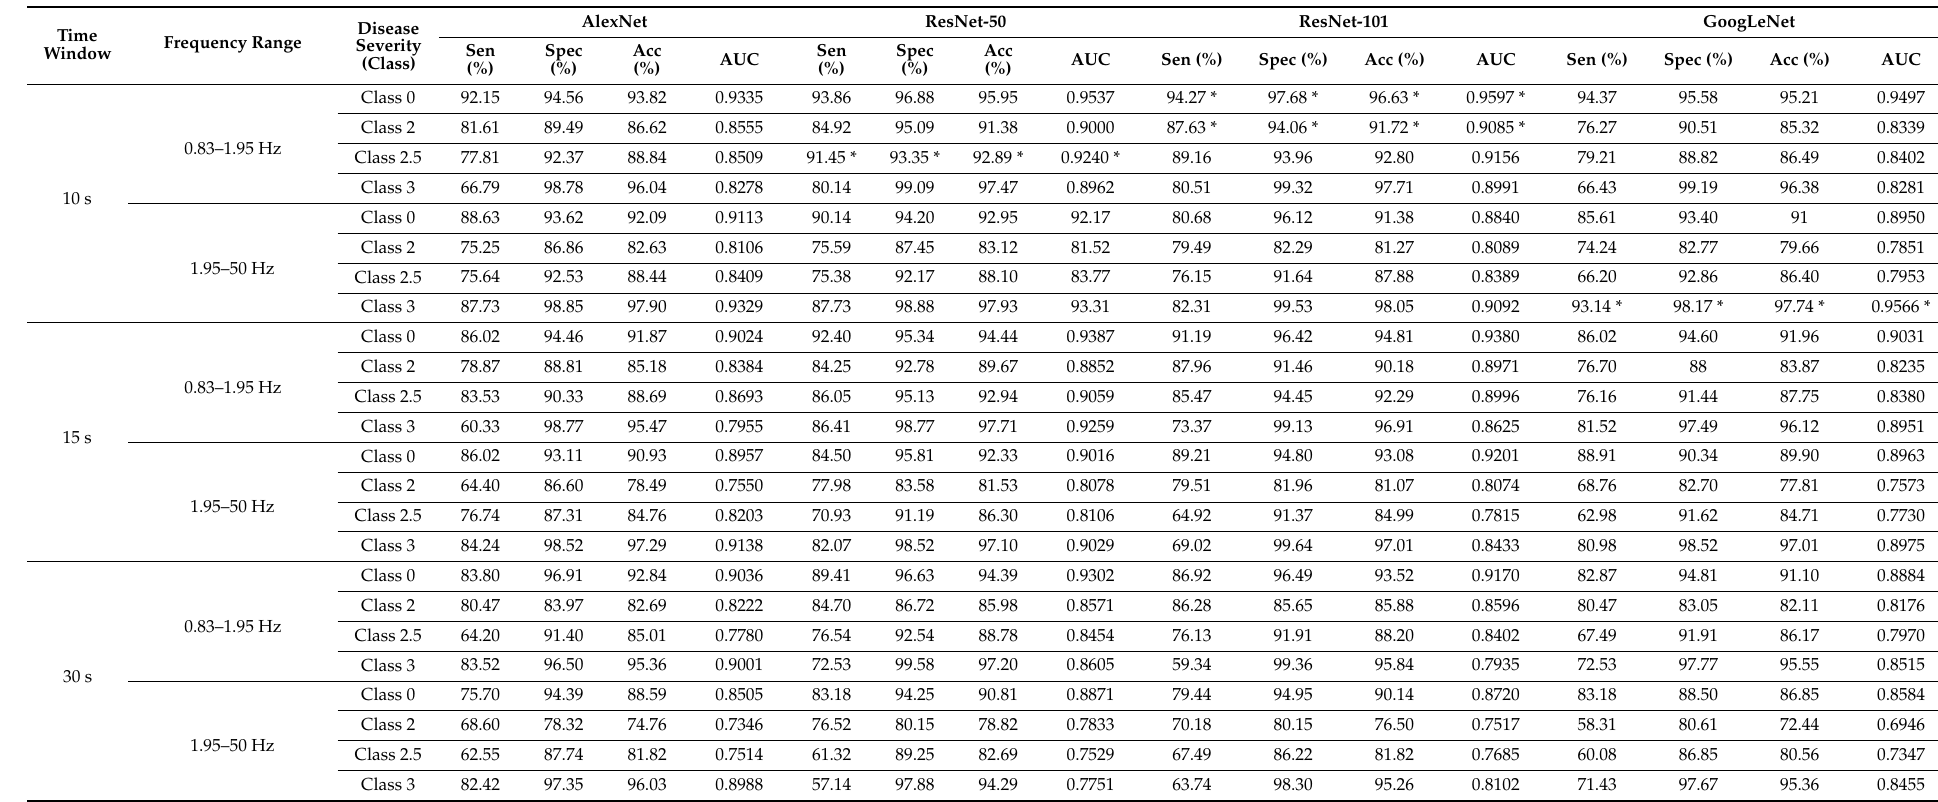
Table 14. Multi-class classification of LF from all datasets for CO (Class 0), PD Stage 2 (Class 2), PD Stage 2.5 (Class 2.5), and PD Stage 3 (Class 3) using several CNN classifiers (AlexNet, ResNet-50, ResNet-101, and GoogLeNet) with 10-fold